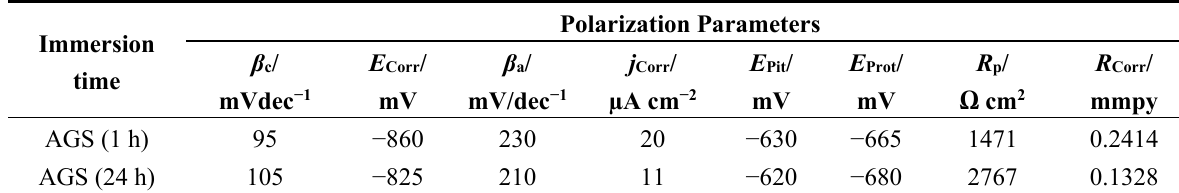
Figure 3. Cyclic potentiodynamic polarization curves obtained for the cast iron electrode after its immersion in AGS solutions for ( a ) 1 h and ( b ) 24 h, respectively. Table 1. Polarization parameters obtained for the cast iron electrode after its immersion for 1 h and 24 h in the Arabian Gulf seawater